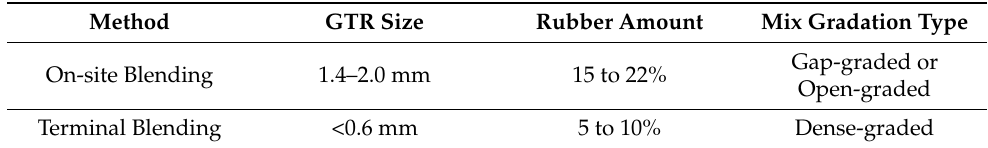
Table 2. Wet process, on-site vs. terminal